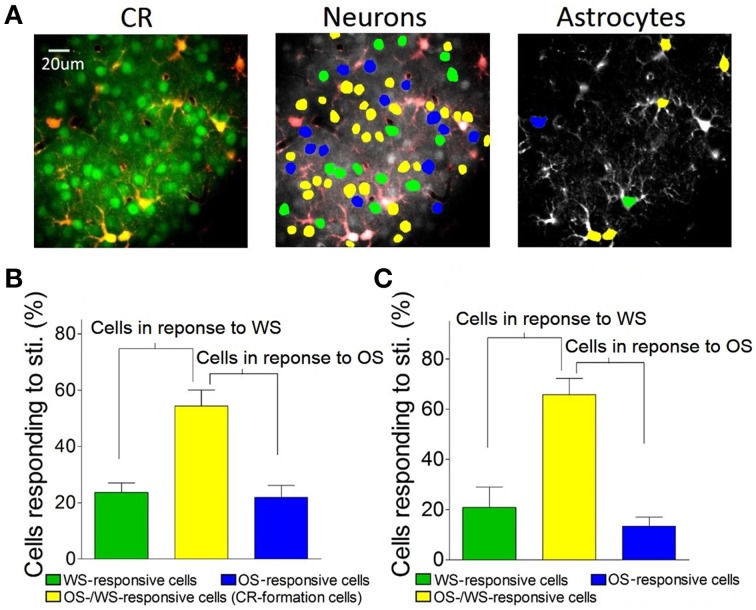
The barrel cortex recognizes whisker and olfaction inputs via organizing different neurons in their responses. (A) Shows Ca2+ imaging in neurons (greens in left panel) and astrocytes (red). The neurons (middle) and astrocytes (right) in response to both OS and WS are labeled as yellow, OS only as blue, or WS only as green. (B) Shows the percentages of WS-responsive neurons (green bar), OS/WS-responsive neurons (yellow), and OS-responsive neurons (blue) from CR-formation mice (n = 5). (C) Illustrates the percentages of WS-responsive astrocytes (green bar), OS/WS-responsive astrocytes (yellow), and OS-responsive astrocytes (blue) from CR-formation mice (n = 5). WS-responsive and OS/WS-responsive cells work together to recognize whisker signal. OS-responsive and OS/WS-responsive cells work together to recognize odor signal.